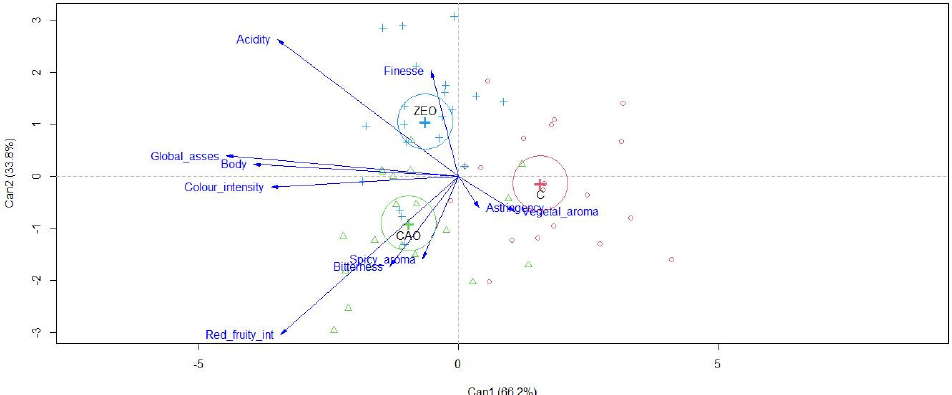
Figure 3. Canonical discriminant analysis (CDA) of the sensory traits for the Sangiovese wines obtained from kaolin (CAO, ∆ ) and chabasite-rich zeolitite (ZEO, + ) treatments or the control (C, ◯ ) vines in 2020. Treatment separation along the canonical discriminant function I (Can 1) and II (Can 2) with class centroids identified by the cross symbol (+).